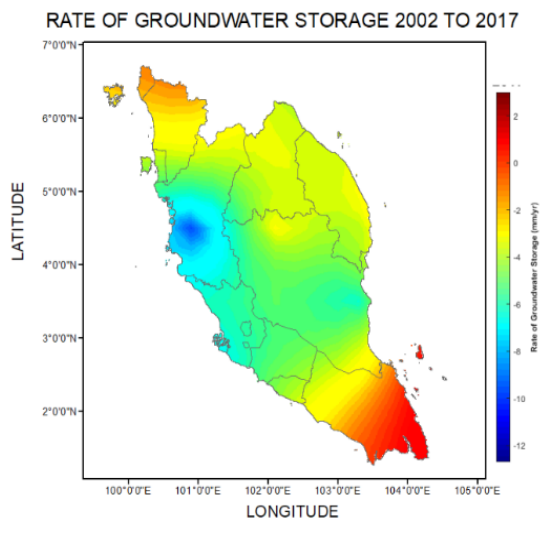
Figure 7. The rate of GWS from 2002 to 2017 in Peninsular